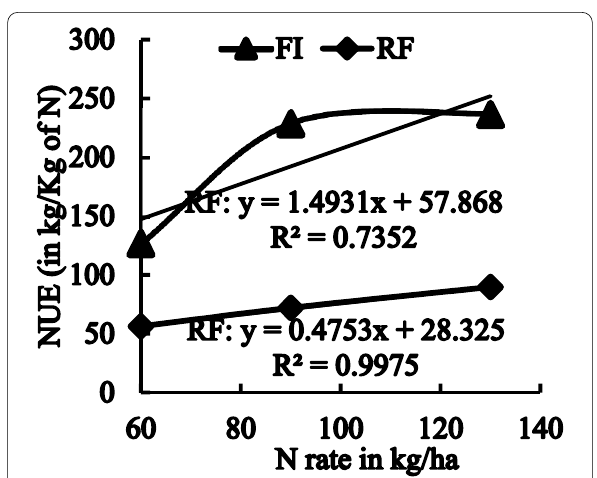
Fig. 8 Relationship between WUE and N-rates under different irrigation treatments